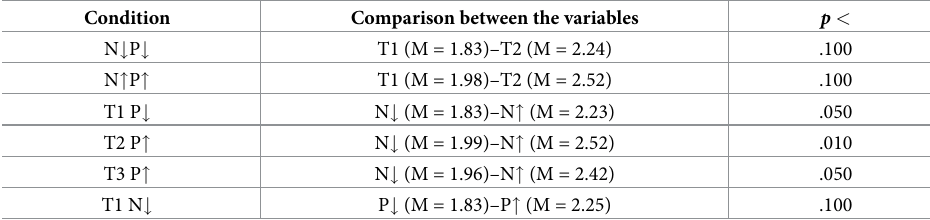
Table 2. Post hoc comparisons–Time abroad (T) � level of Negative experiences (N) � level of Positive experiences (P).